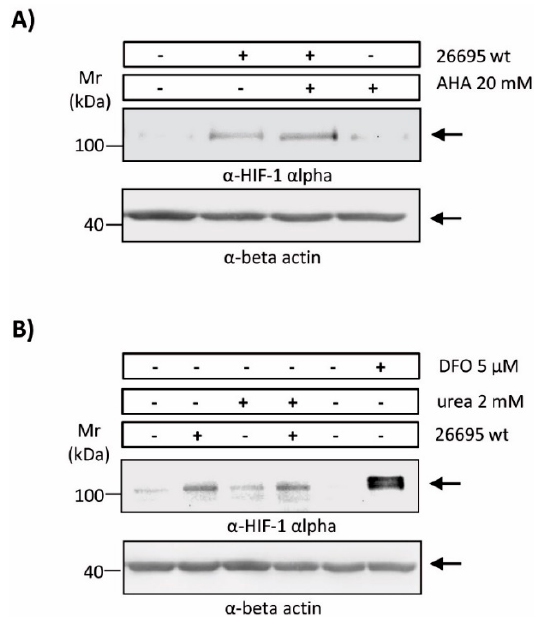
Figure 4. Induction of HIF-1 α by H. pylori in the presence of AHA or urea in gastric epithelial cells. AGS cells were infected with H. pylori 26695 at MOI 100 for 8 h. Protein extracts were prepared and HIF-1 α and β -actin protein levels were analyzed by Western blotting. Experiments were performed in the presence / absence of ( A ) the urease inhibitor AHA 20 mM or ( B ) urea 2 mM. Deferoxamine (5 µ M) was included as a positive control for HIF-1 induction in normoxic conditions.